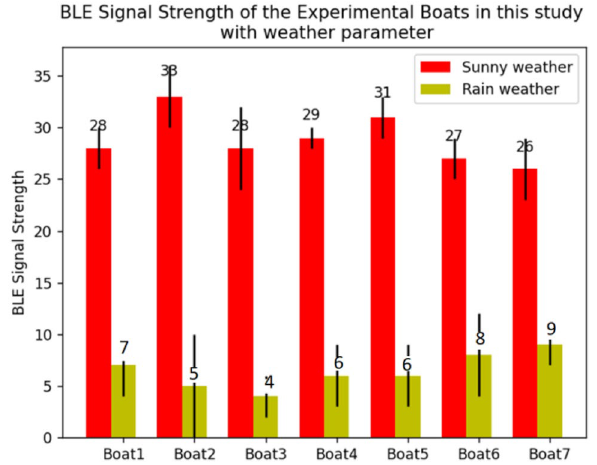
Fig. 11 Experimental result of BLE signal strength with sea wave parameter a red line indicated BLE signal strength in shallow waters sea wave; b brown line indicated BLE signal strength in tidal water sea